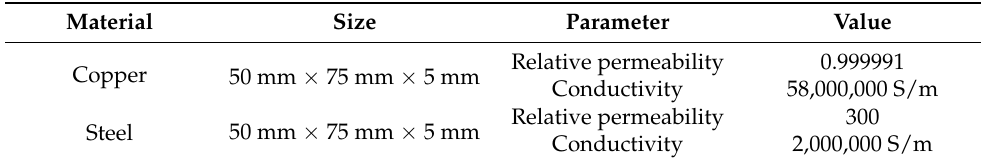
Table 3. The parameters of metal foreign object.